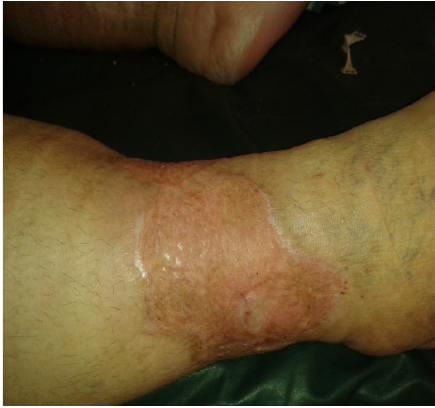
Fig. 3. 3 weeks after begin of